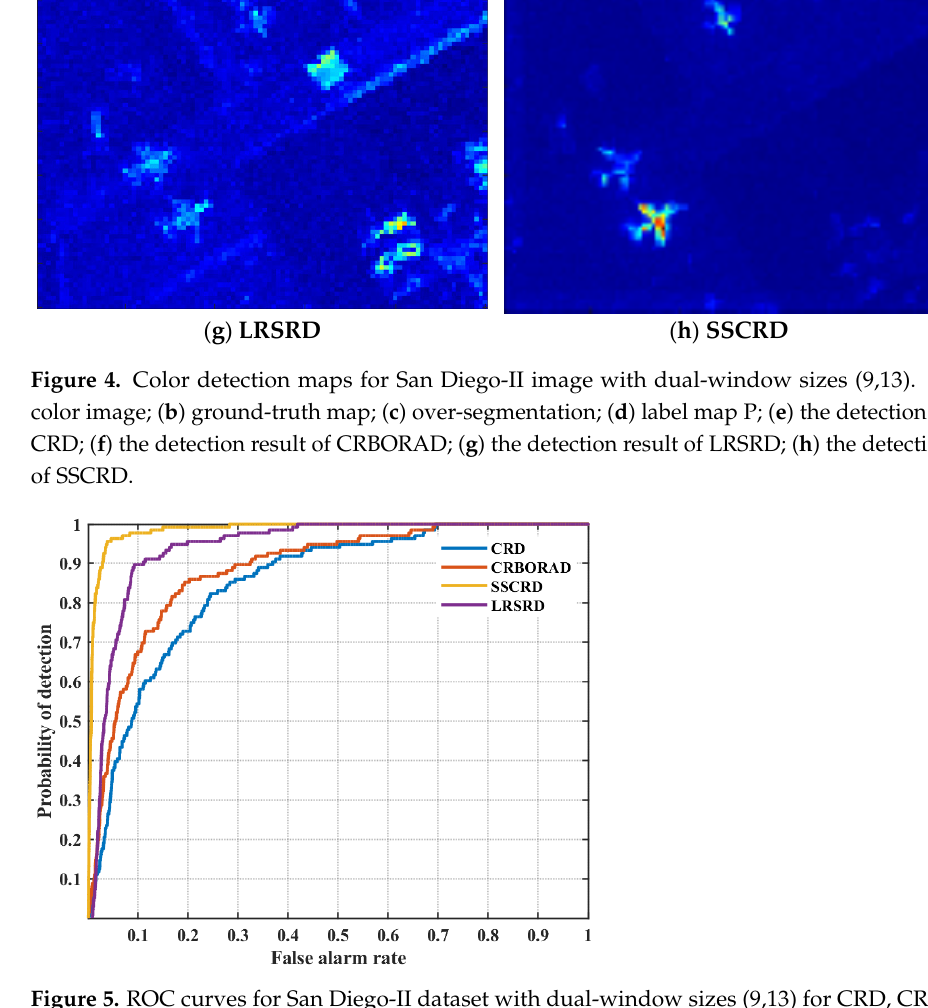
Figure 4. Color detection maps for San Diego-II image with dual-window sizes (9,13). ( a ) False color image; ( b ) ground-truth map; ( c ) over-segmentation; ( d ) label map P; ( e ) the detection result of CRD; ( f ) the detection result of CRBORAD; ( g ) the detection result of LRSRD; ( h ) the detection result of SSCRD.